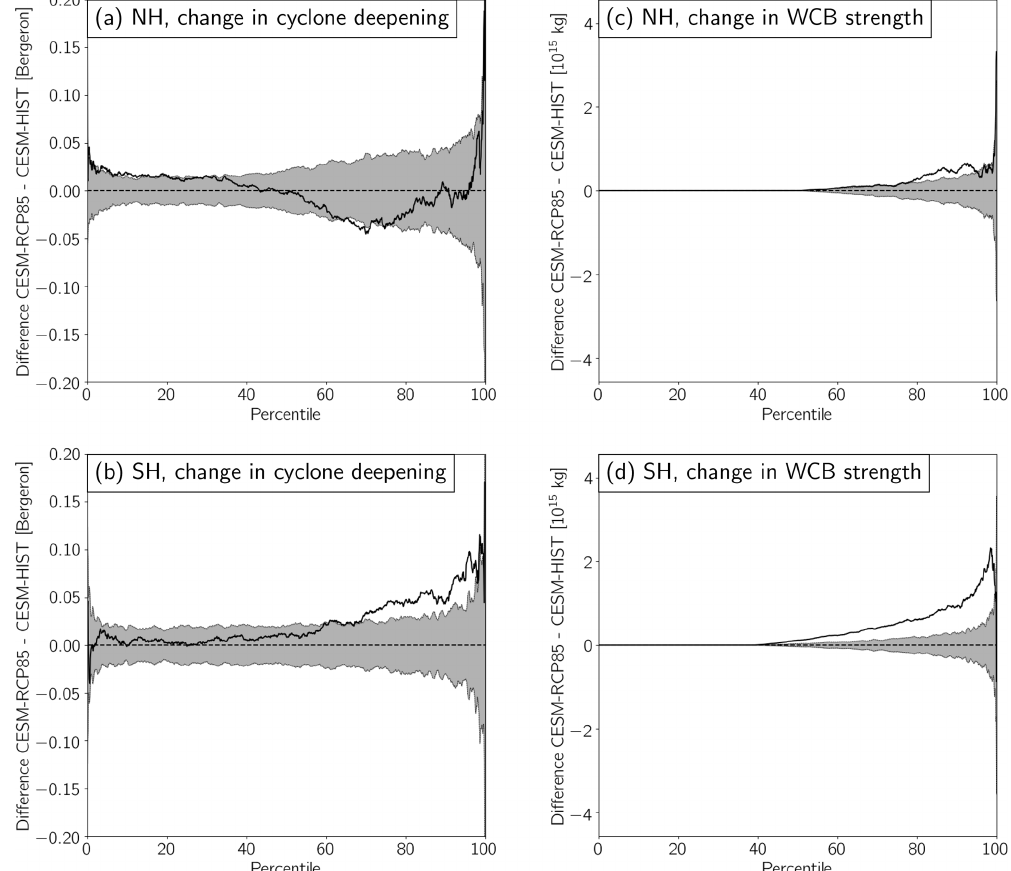
Figure 4. The black line shows the difference in the percentile curves between the future and the present-day climate simulations (CESM- RCP85 minus CESM-HIST) of (a, b) cyclone-deepening rates (cid:49) SLP B , max (bergeron) and (c, d) WCB strength associated with the cyclones (10 15 kg) in (a, c) NH winter and (b, d) SH winter. The grey shading corresponds to the 95% confidence interval of the differences under the null hypothesis that the values in CESM-HIST and CESM-RCP85 belong to a common distribution. It has been obtained by calculating 100000 resamples of the difference in the percentile distribution from two randomly drawn equally sized samples (see text for